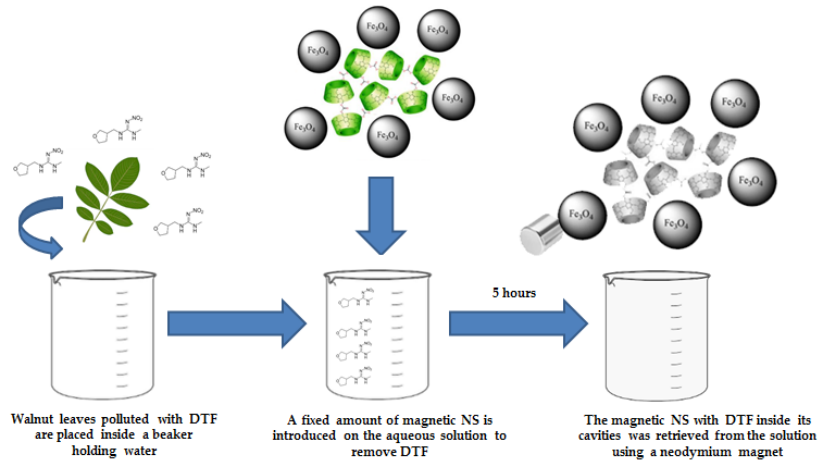
Figure 9. Schematic representation of DTF removal and retrieval of magnetic NSs.